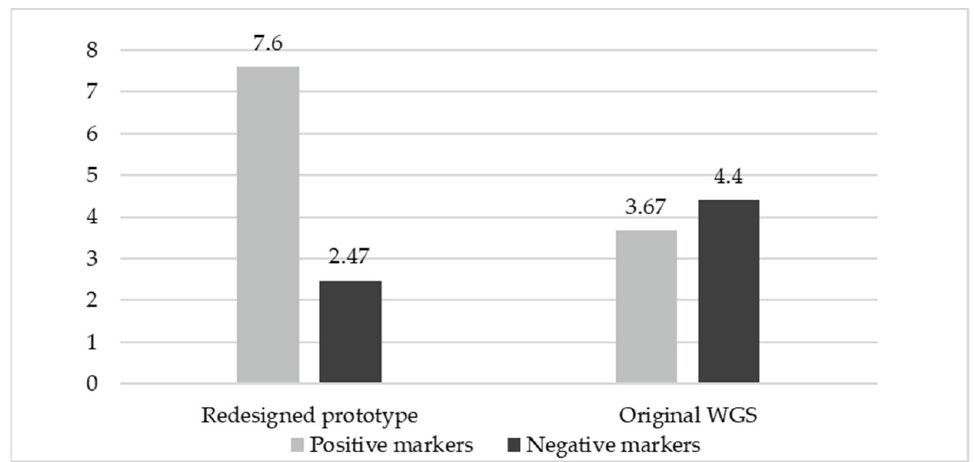
Figure 5. Comparison between both types of WGS regarding positive and negative markers (average frequency).